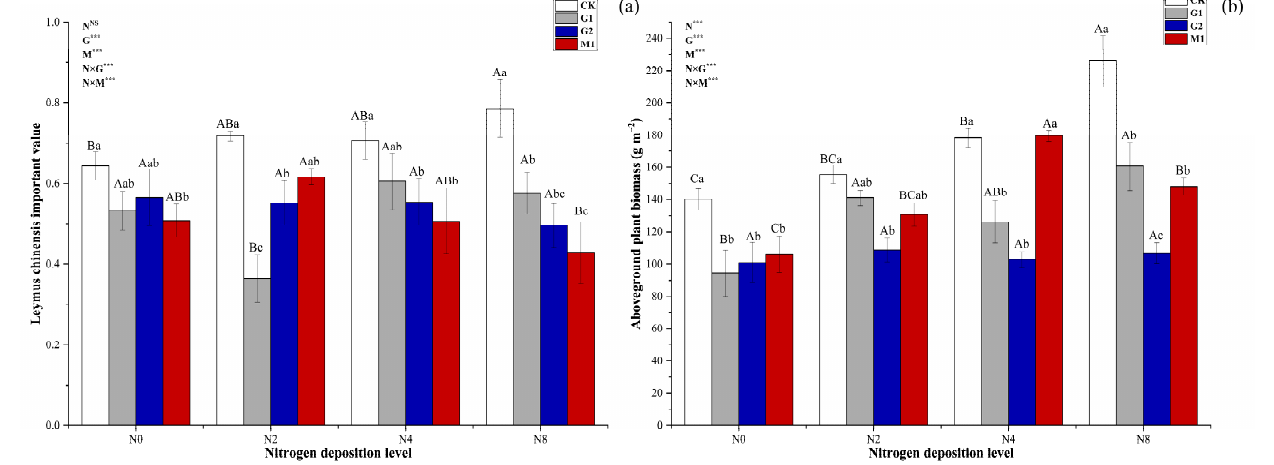
Figure 3. Effects of grazing sheep (G1, G2) and mowing (M1) on plants at different nitrogen deposition levels (N0, N2, N4, N8); ( a ) Leymus chinensis importance value; ( b ) Above-ground plant biomass. Different lowercase letters indicate significant differences among different treatments under the same nitrogen deposition level ( p < 0.05); different capital letters indicate significant differences among different nitrogen deposition levels under the same treatment ( p < 0.05). Significant effects of treatments are marked with an asterisk. Triple asterisks evaluate the significance level at p < 0.001, and NS indicates no significant difference.